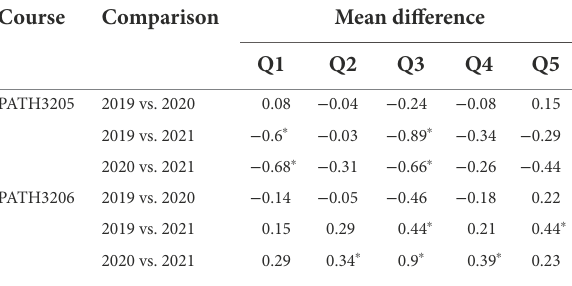
TABLE 2 Mean differences of student feedback in all domains assessed, compared against each calendar year, per course. Course